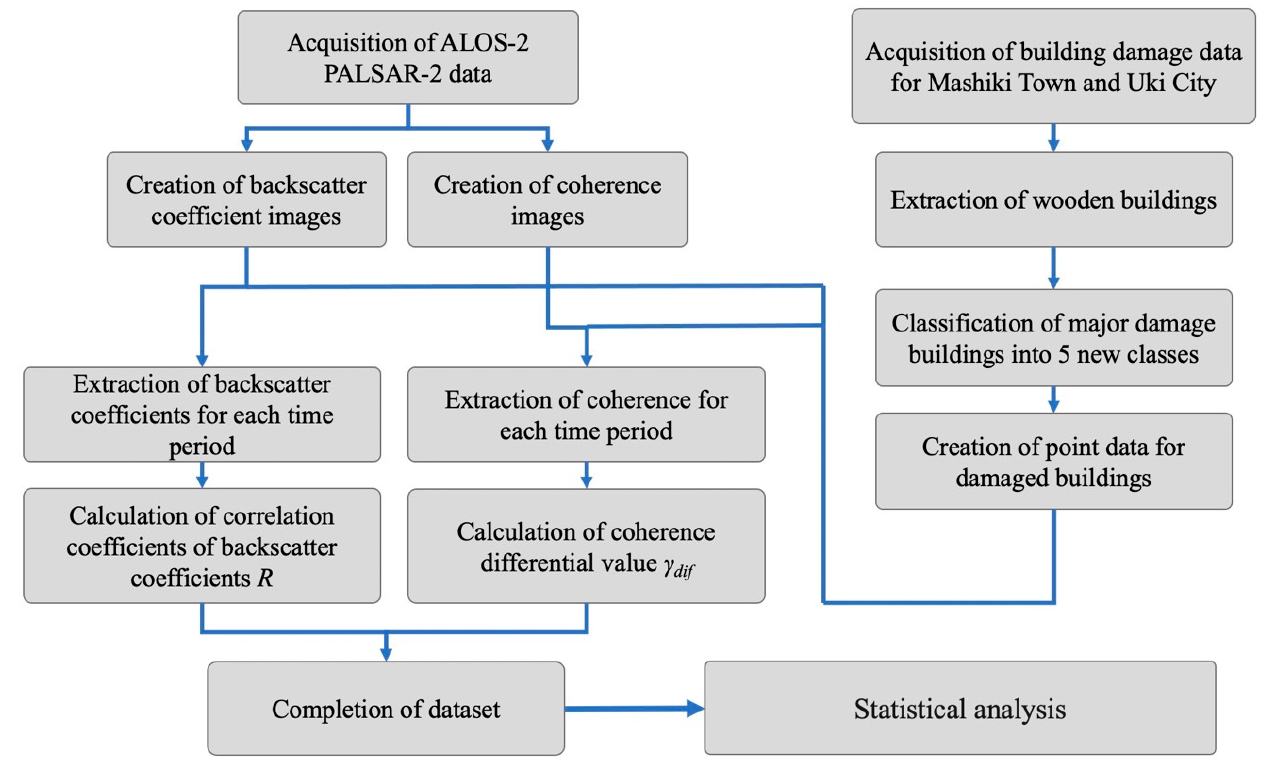
Figure 4. Flowchart of the research process. The SAR images and the point data representing the building center were created and superimposed to obtain the SAR images parameters at each building. R and γ dif were calculated from the parameters for each building to create a dataset, which was then used for statistical analysis.